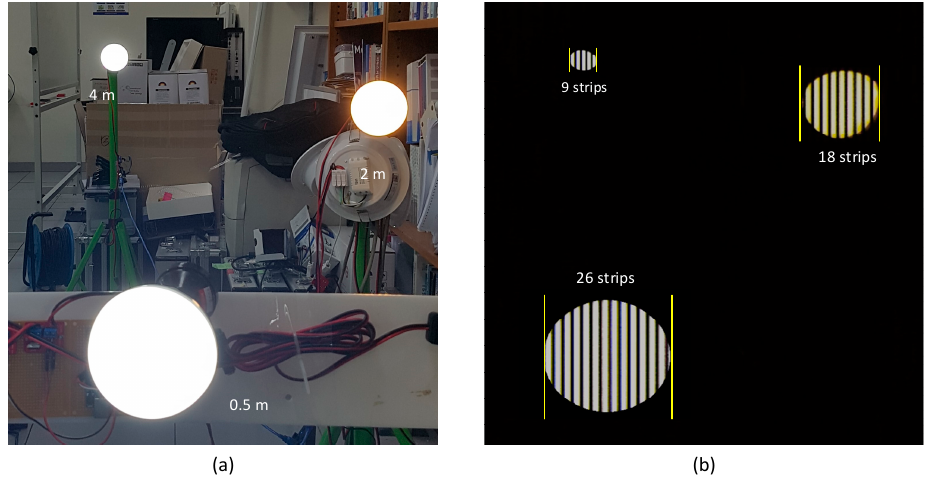
Figure 7. Distance problem visualization for a smartphone-based OCC system. ( a ) LEDs at various distances, ( b ) image of LEDs after changing the exposure duration to 1/8000 s.